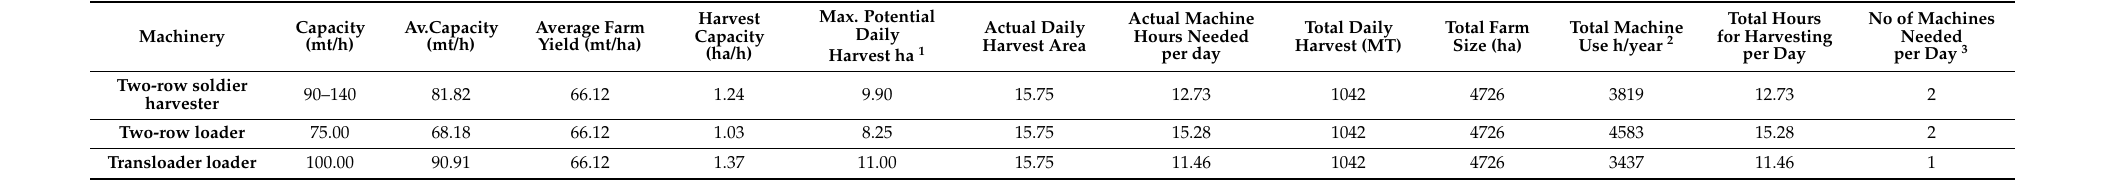
Table 2. Estimated number of harvesters and loading machine requirements for energycane.